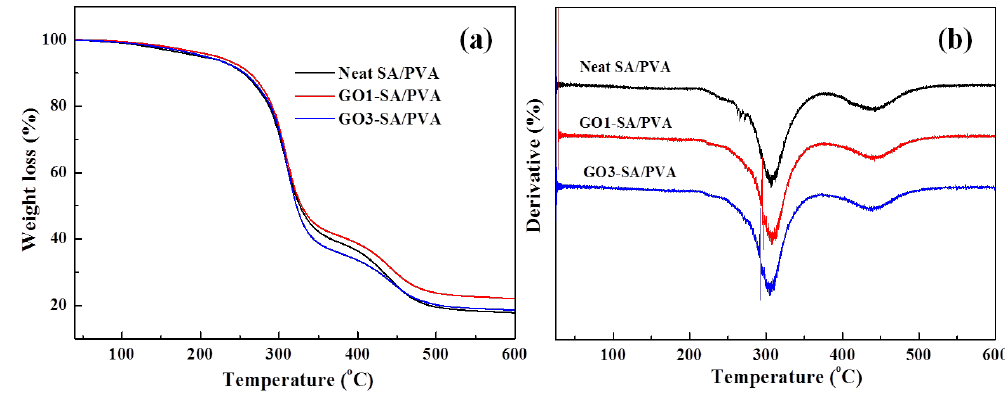
Figure 3. ( a ) TGA and ( b ) differential thermogravimetric analysis (DTG) curves of DN hydrogel and GO reinforced DN hydrogels composites.